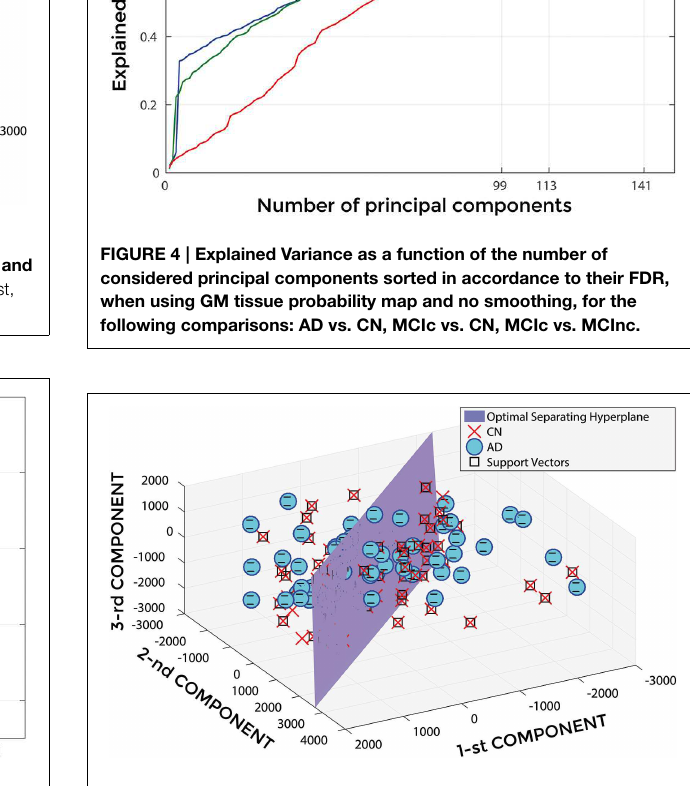
FIGURE 5 | Hyper-plane plane separating AD (o symbol) from CN ( × symbol) PCA coefficients (3 PCA coefficients), and defined Support Vectors ( 2 symbol), when using GM tissue probability map and an isotropic Gaussian kernel with 10mm 3 FWHM for smoothing. 1st, 2nd, and 3rd components are